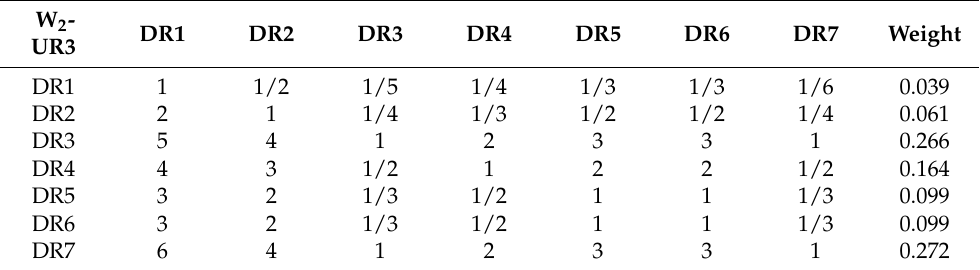
Table A2. Calculating relative weights of DRs in terms of UR3 through pairwise comparison to determine W2.